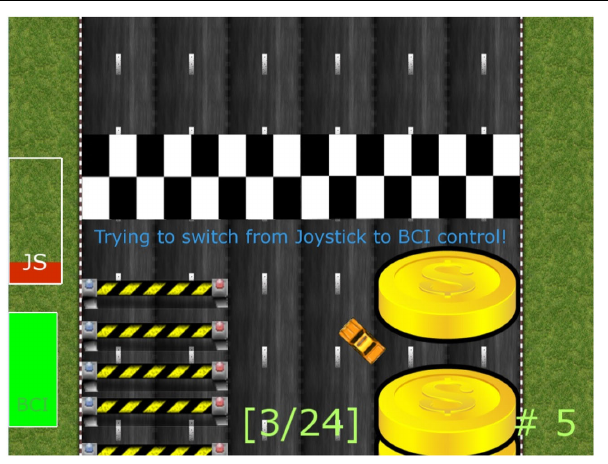
FIGURE 1 | Online car game. The current trial’s task is to collect coins on the right side and to avoid the barriers on the left.The active mode is still JS, but a switch to BCI is imminent due to the low quality of the JS input, visualized with a quality bar on the left screen side.The current score in relation to the maximum possible score at the moment is displayed on the bottom of the screen.The right number indicates the number of the active trial.The finish line depicts the end of a trial after which the switching is carried